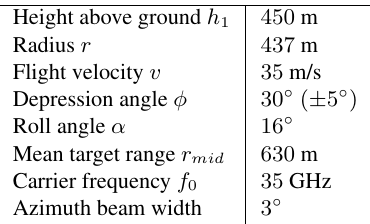
Table 1: Flight and Sensor